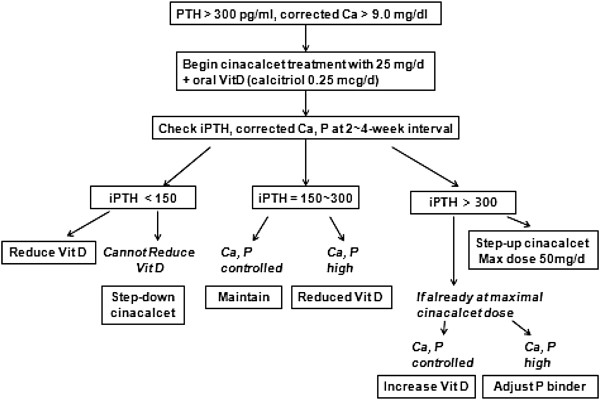
Dose titration algorithm for cinacalcet and vitamin D in the cinacalcet group during dose-titration period. Initially, cinacalcet group started with 25 mg/day of cinacalcet p.o. and the cinacalcet dose was, in a stepwise pattern, increased at a 4-week interval to 50 mg/day to achieve an iPTH target between 150 and 300 pg/ml. iPTH, intact parathyroid hormone; Ca, calcium; P, phosphorus; Vit D, vitamin D.